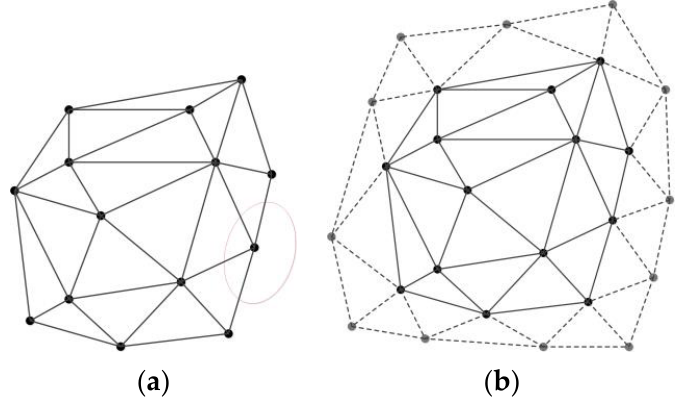
Figure 5. Boundary triangulation optimization. ( a ) Triangular mesh on only one side of the border and ( b ) optimized triangulation results. The solid line represents the original triangulation result, and the dotted line is the triangulation result after adding the convex hull points.